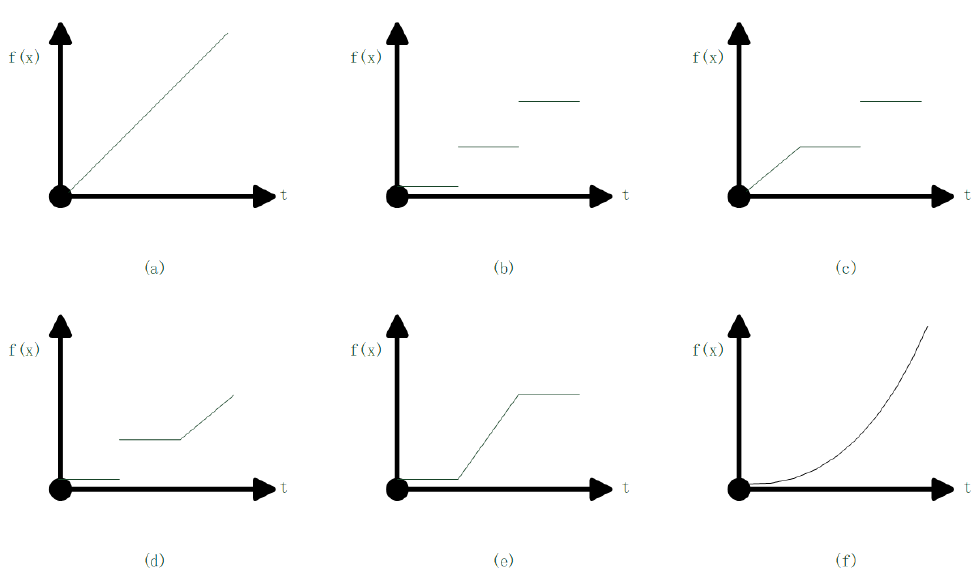
Fig. 1 User experience